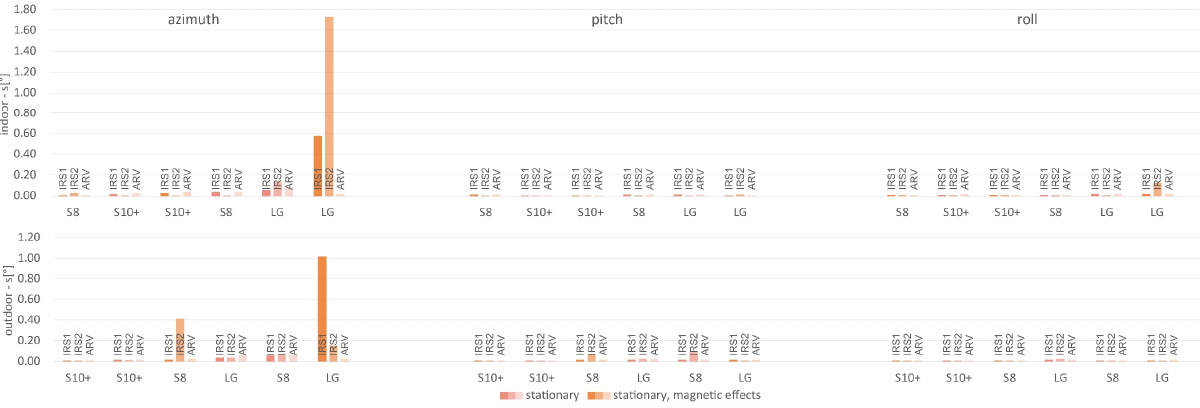
Figure 4. Stability investigation of smartphone-based rotation parameters. Stability is defined by the standard deviation s of one measurement series when the smartphone was used in static